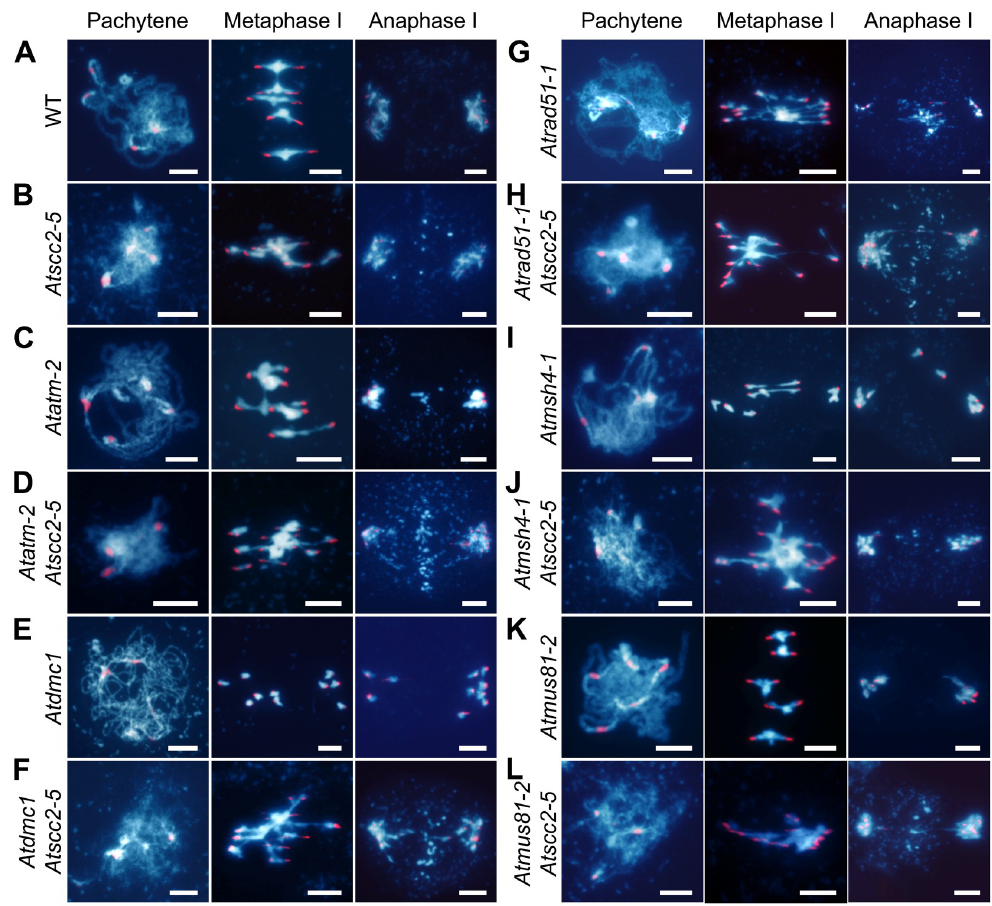
Fig 5. Genetic analyses of AtSCC2 in meiotic recombination mutants. DAPI stained chromosome spreads at pachytene, metaphase I and anaphase I in (A) WT, (B) Atscc2-5 , (C) Atatm-2 , (D) Atatm-2 Atscc2-5 , (E) Atdmc1 , (F) Atdmc1 Atscc2-5 , (G) Atrad51-1 , (H) Atrad51-1 Atscc2-5 , (I) Atmsh4-1 , (J) Atmsh4-1 Atscc2-5 , (K) Atmus81-2 , (L) Atmus81-2 Atscc2-5 . Bar = 5 μ m.